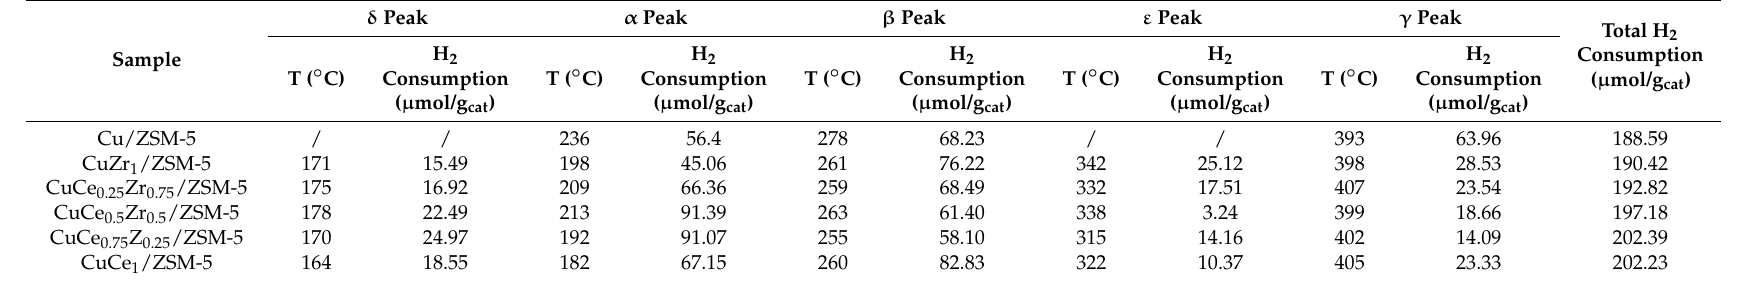
Table 2. H 2 -TPR results from Cu/ZSM-5 and CuCe x Zr 1 − x /ZSM-5 catalysts ( x = 0, 0.25, 0.5, 0.75,